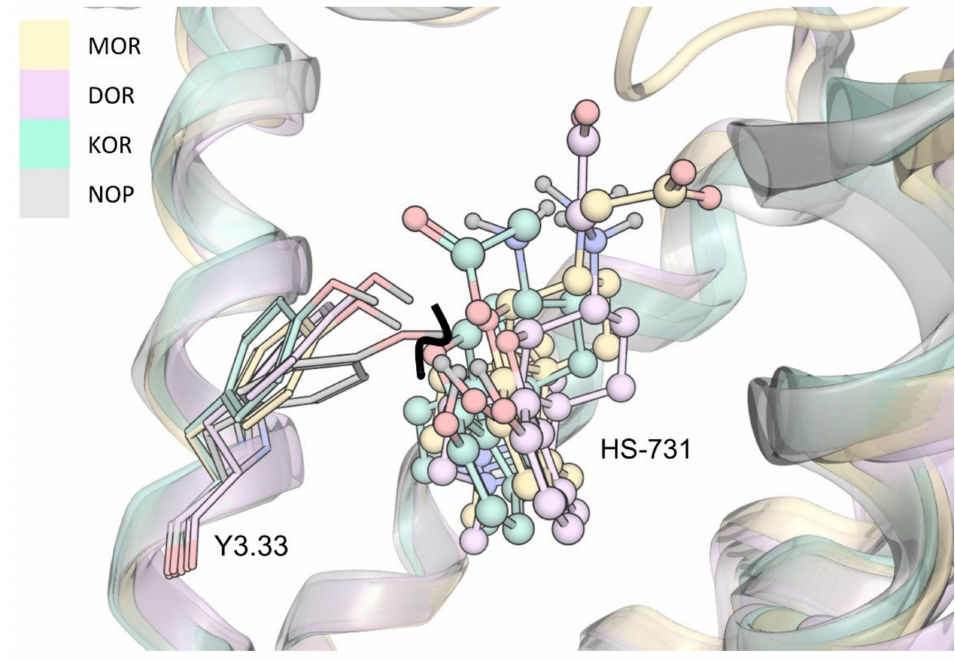
Figure 6. Superimposition of the NOP receptor and the classical opioid receptors in complex with HS-731. Atom clash is indicated by the bold black